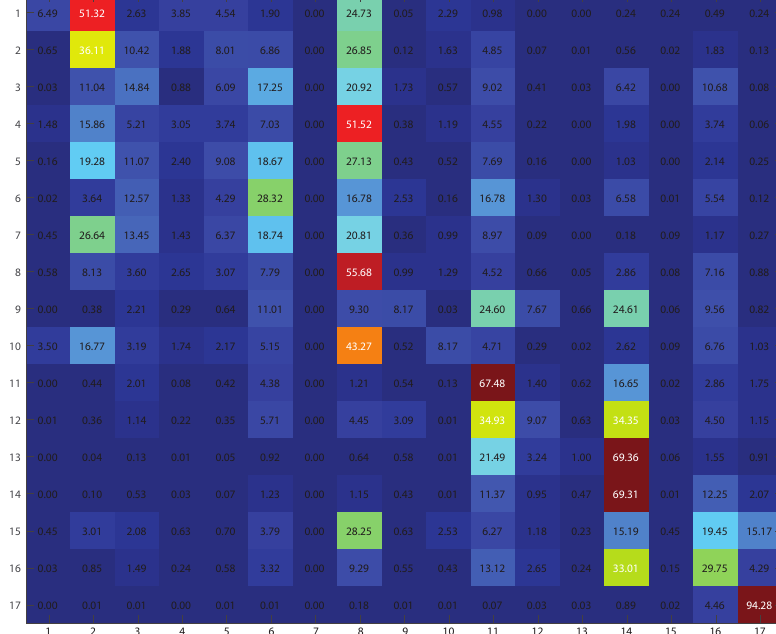
Figure 10. Confusion matrix of the classification framework on feature combination E , which is the best feature combination in terms of OA. Numbers are reported in